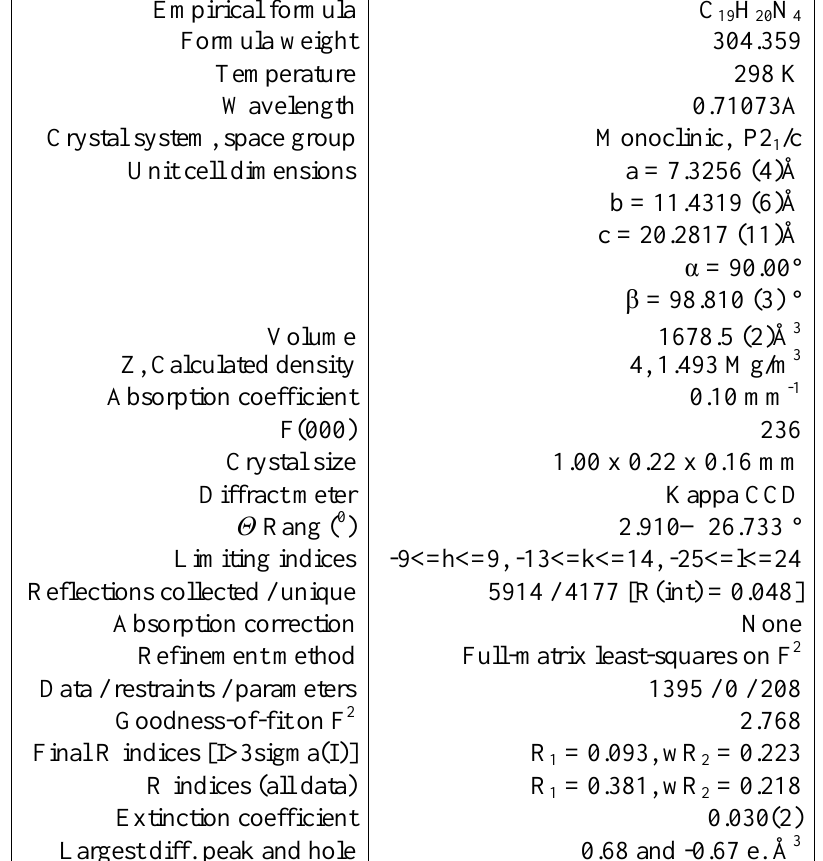
Table 2. Crystallographic and experimental data of compound